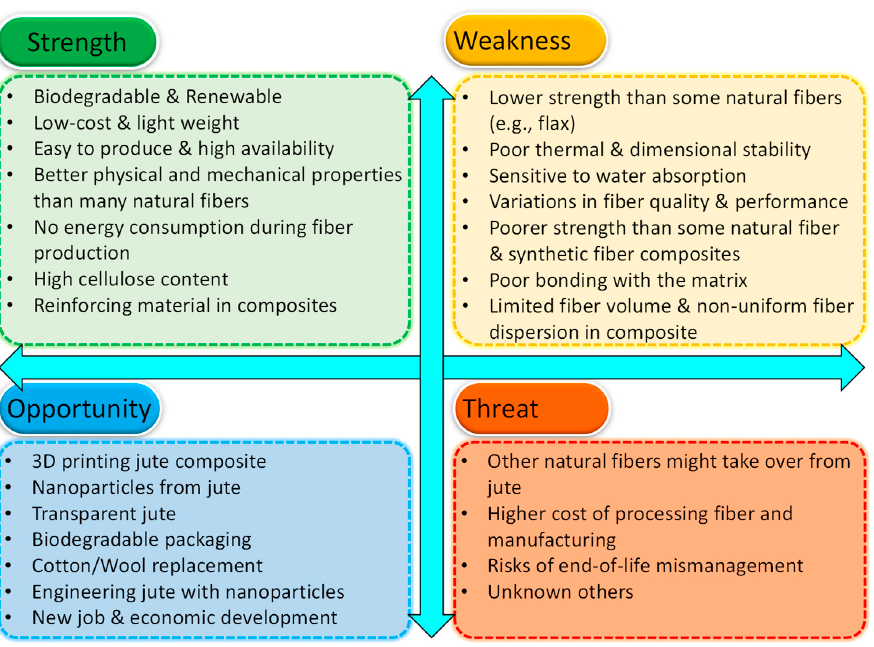
Figure 26. SWOT analysis of jute fiber and its associated products.